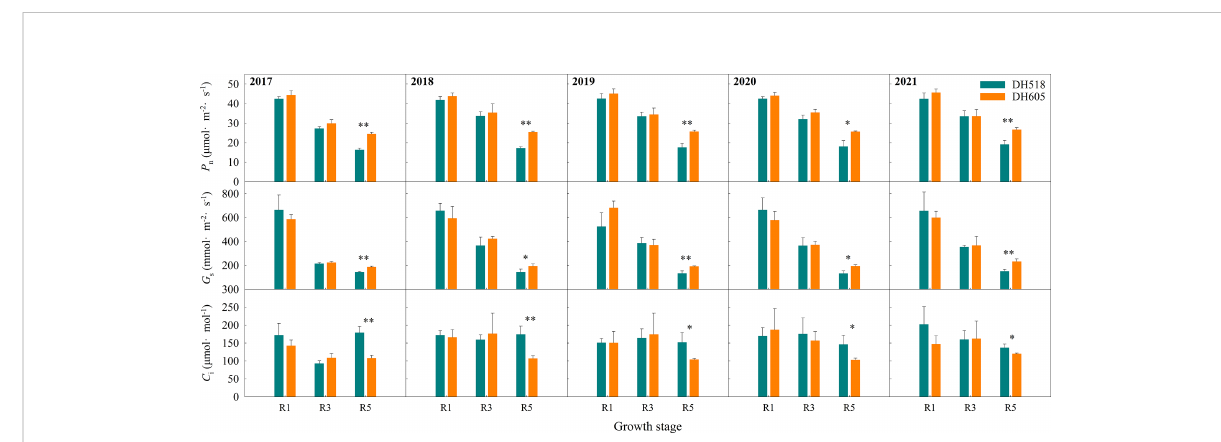
FIGURE 5 Post-silking changes of gas exchange parameters in leaves of summer maize hybrids with different growth duration (2017-2021). 2017, 2018, 2019, 2020 and 2021 were different years; DH518, Denghai518; DH605, Denghai605. R1, R3 and R5 were silking stage, milk stage and 45 days after silking. P n , the net photosynthetic rates; G s , stomatal conductance; C i , intercellular CO 2 concentration. ** and * indicated signi fi cantly different at the 0.01 and 0.05 probability levels, respectively.